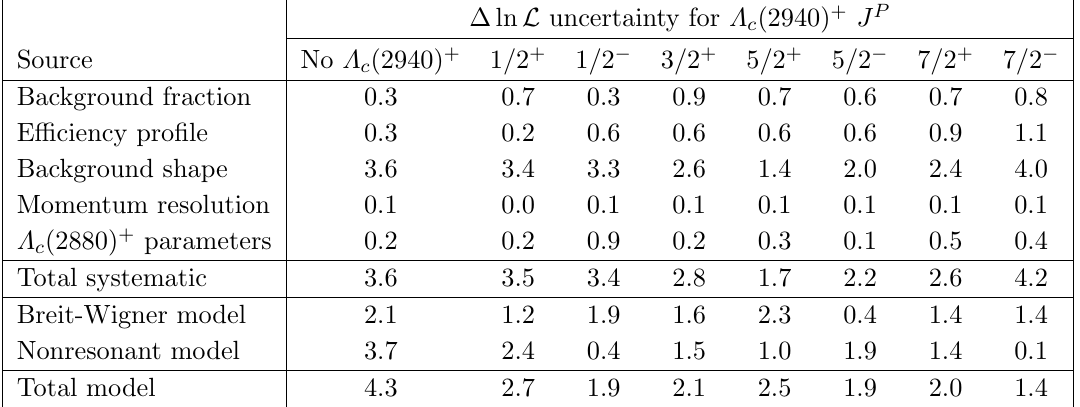
Table 10 . Systematic and model uncertainties on (cid:1) ln L between the baseline (cid:12)t with J P = 3 = 2 (cid:0) for the (cid:3) c (2940) + state and other (cid:12)ts without a (cid:3) c (2940) + contribution or with other spin-parity assignments, for the exponential nonresonant model.